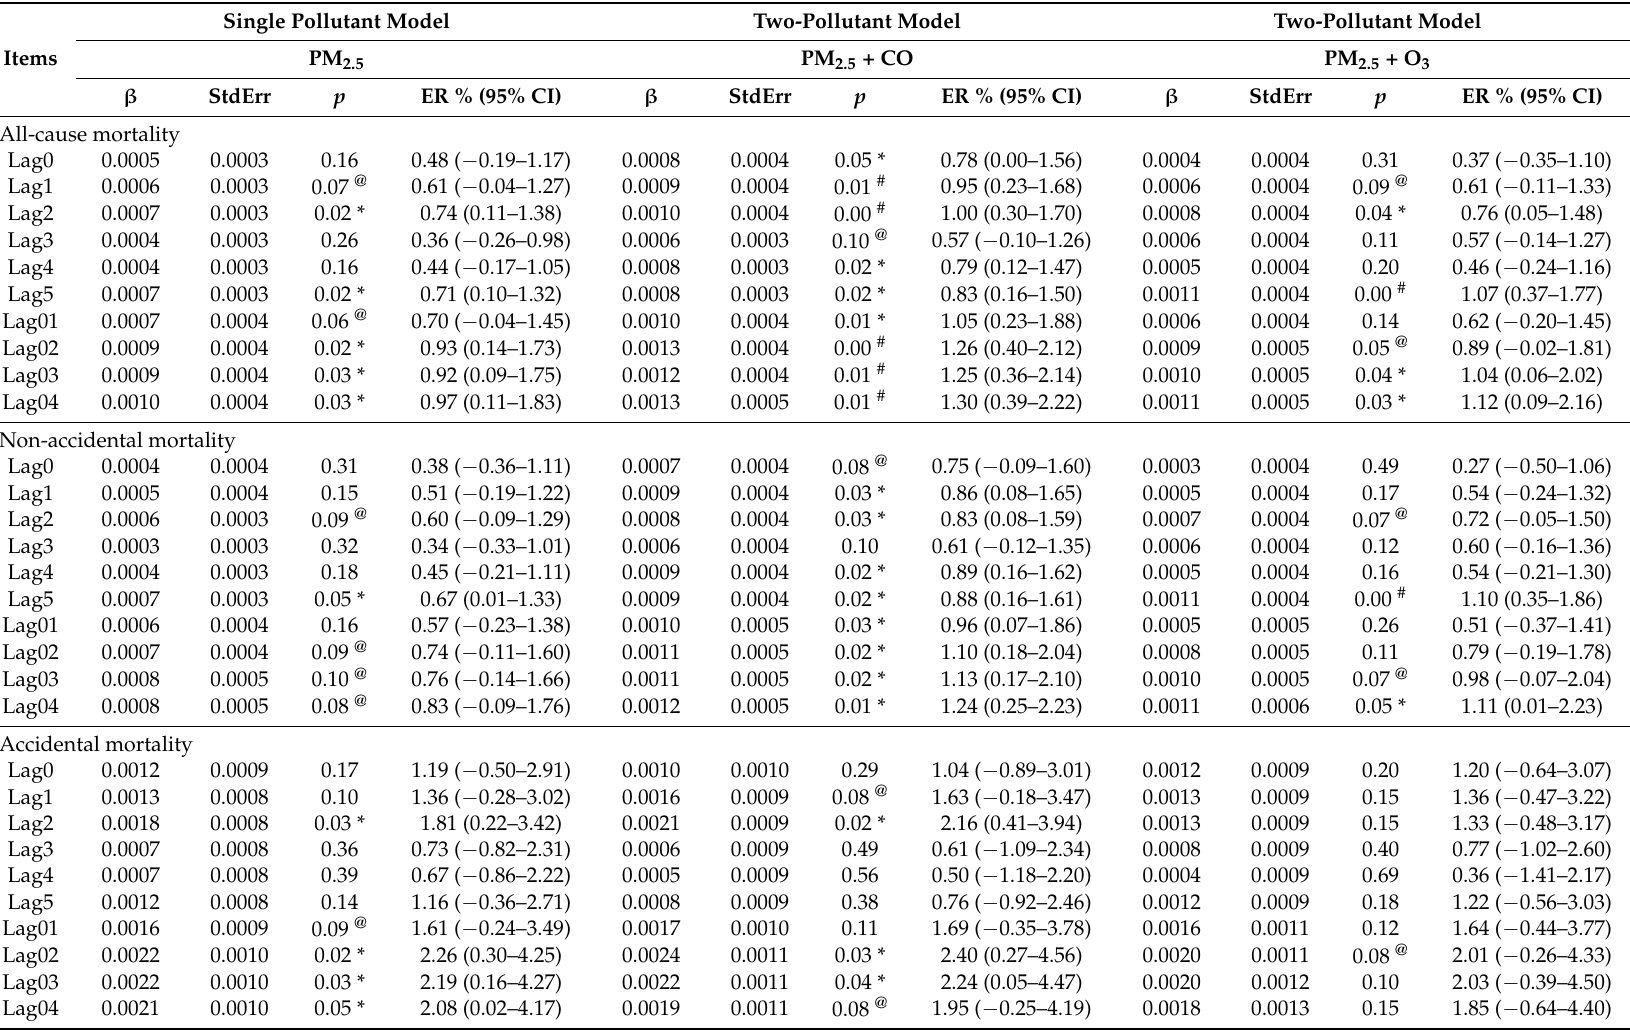
Table 3. The effects of PM 2.5 concentration on residents’ mortality without controlling other pollutants and after controlling CO or O 3 in Shenzhen